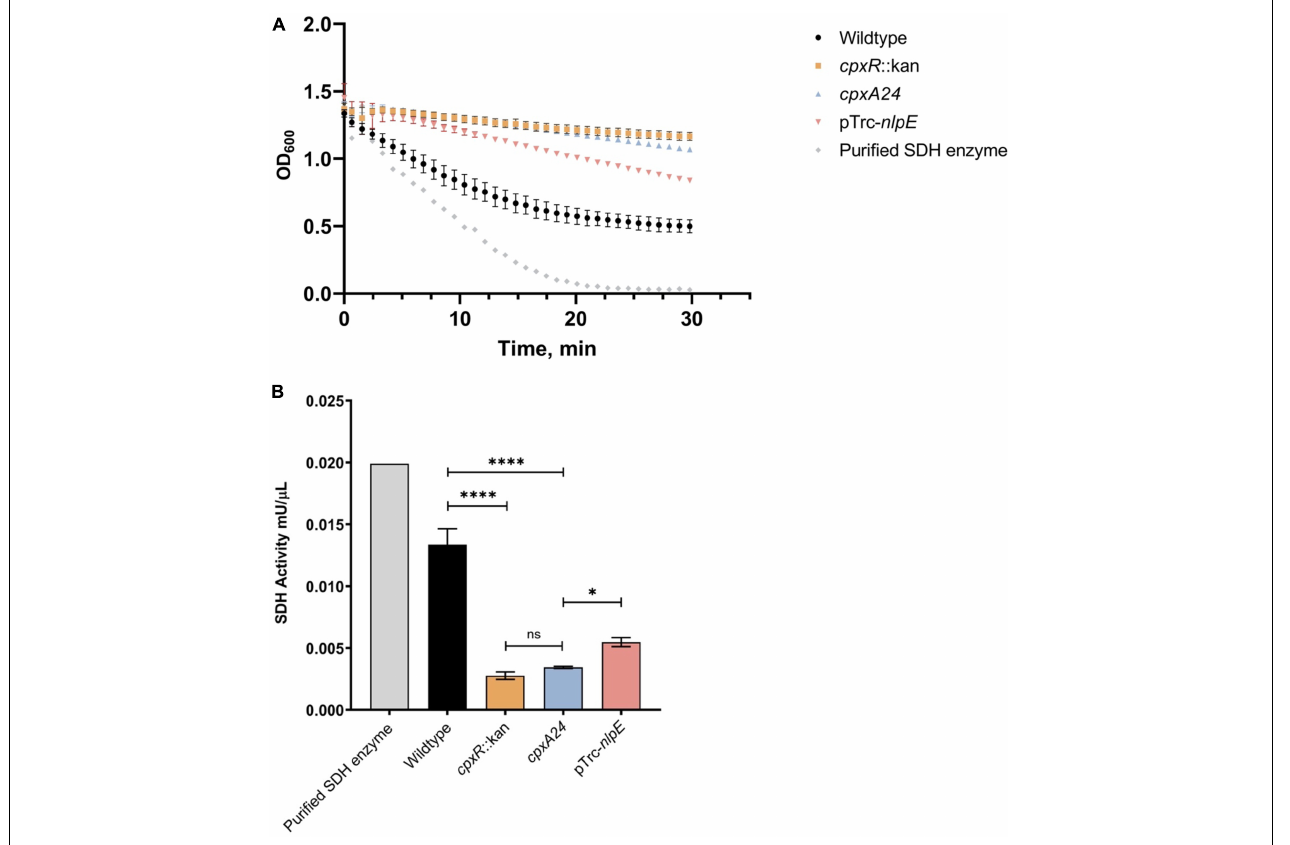
FIGURE 2 | Succinate dehydrogenase (SDH) activity is reduced by excessive activation or absence of the functional Cpx response. Wildtype MC4100, cpxR ::kan, cpxA24 and MC4100 harboring NlpE overexpression plasmid (pTrc- nlpE ) were subcultured from their overnight cultures 1:50 into 5 mL fresh LB and grown to OD 600 ∼ 0.5 at 37 ◦ C with shaking. 1 mL samples, standardized to the same optical density OD 600 , were pelleted, and cell pellets were resuspended in 200 µ L of ice-cold SDH Assay Buffer (Abcam). Samples were prepared as per manufacturers’ protocol, loaded into a 96-well plate, and mixed with 50 µ L of SDH reaction mix (Abcam). (A) Assay data showing reduction of the DCIP artificial electron acceptor, accompanied by the color change of the dye from blue to colorless (A 600 ). Absorbance at 600 nm was measured every minute for 30 mins at 25 ◦ C with shaking using the Cytation5TM Cell Imaging Multi-Mode Reader (BioTek). (B) Succinate dehydrogenase activity of each sample was calculated as per manufacturers’ protocol and plotted. All data correspond to the means and standard deviations of three replicate cultures. Asterisks indicate a statistically significant difference from the relevant wildtype control [ ∗∗∗∗ P ≤ 0.0001 (one-way ANOVA with Tukey’s post hoc test)]. NS indicates no statistically significant difference in SDH